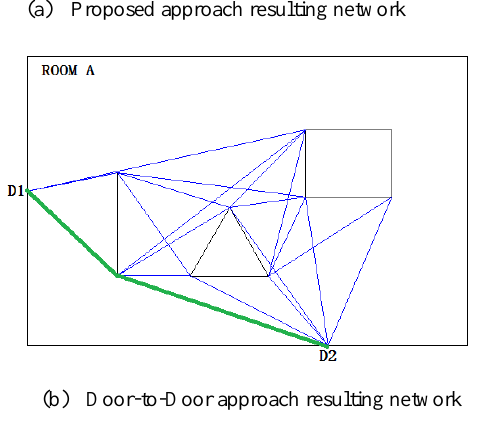
Figure 8. Comparison between the proposed and